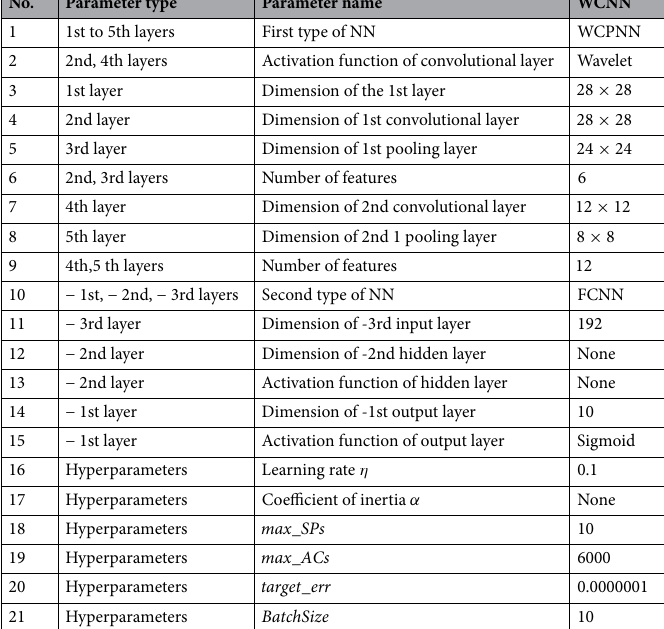
Table 7. Configurations of WCNN